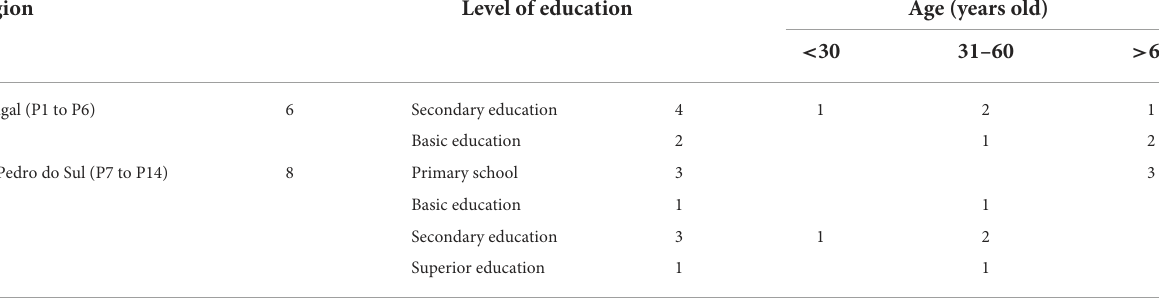
TABLE 1 Sociodemographic characteristics of the participants (number of participants). Region Level of education Age (years old)